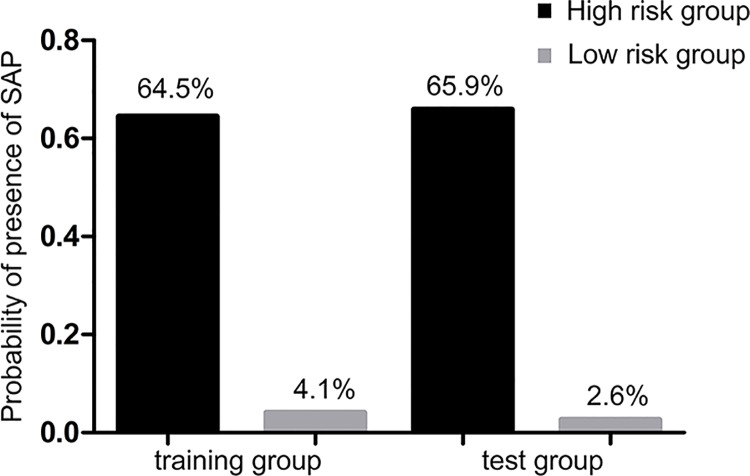
Patients stratified by the tree model in the training and the test groups.